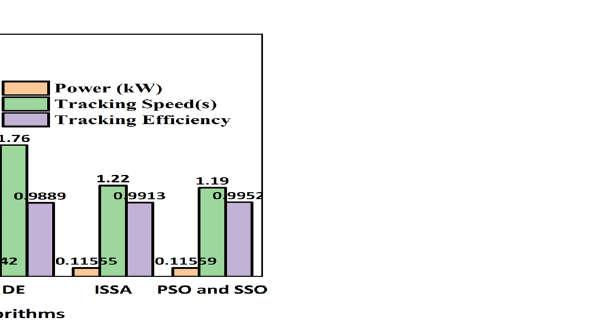
Figure 11. Comparative analysis of the proposed and existing methods 37 in terms of various performance